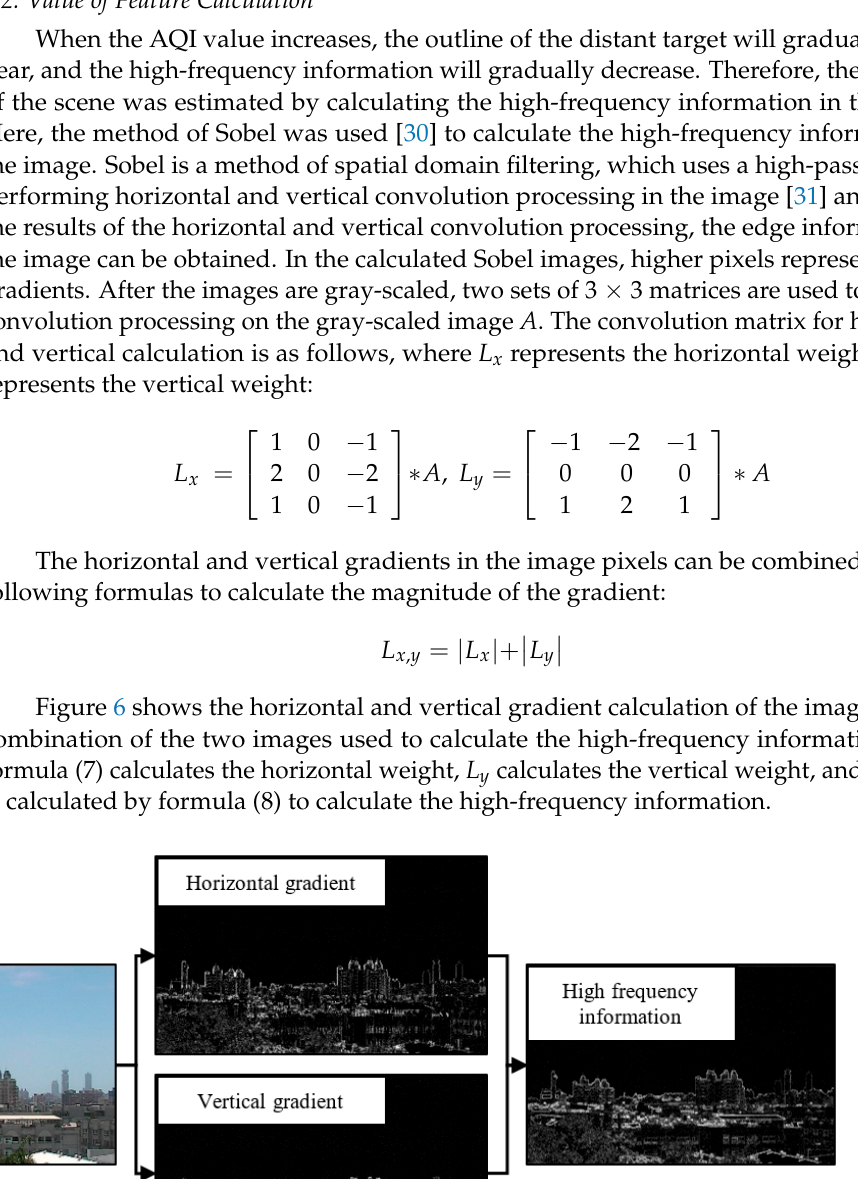
Figure 5. The distribution of AQI and RH values at Renwu Monitoring Station in Kaohsiung, Tai- wan; ( a ) AQI value distribution and ( b ) RH value distribution.